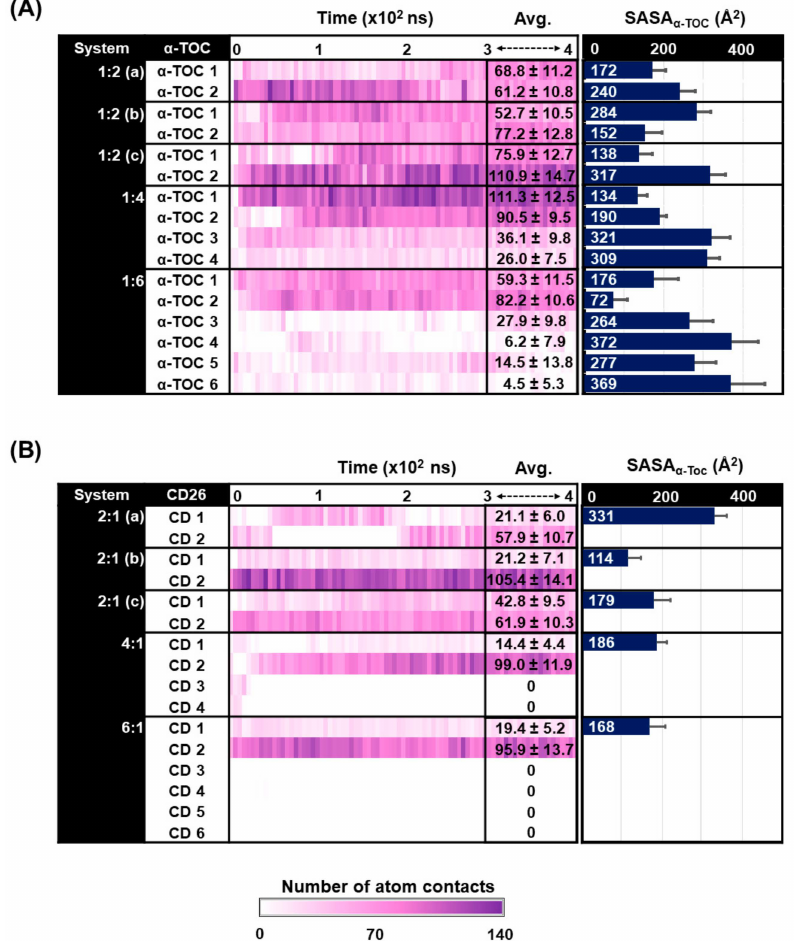
Figure 5. ( A ) The number of atom contacts in the 1:2 (a), 1:2 (b), 1:2 (c), 1:4, and 1:6 complexes (with varying numbers of α -tocopherol molecules) and the SASAs of α -tocopherol in each complex. ( B ) The number of atom contacts in the 2:1 (a), 2:1 (b), 2:1 (c), 4:1, and 6:1 complexes (with varying numbers of CD26 molecules) and the SASAs of α -tocopherol in each